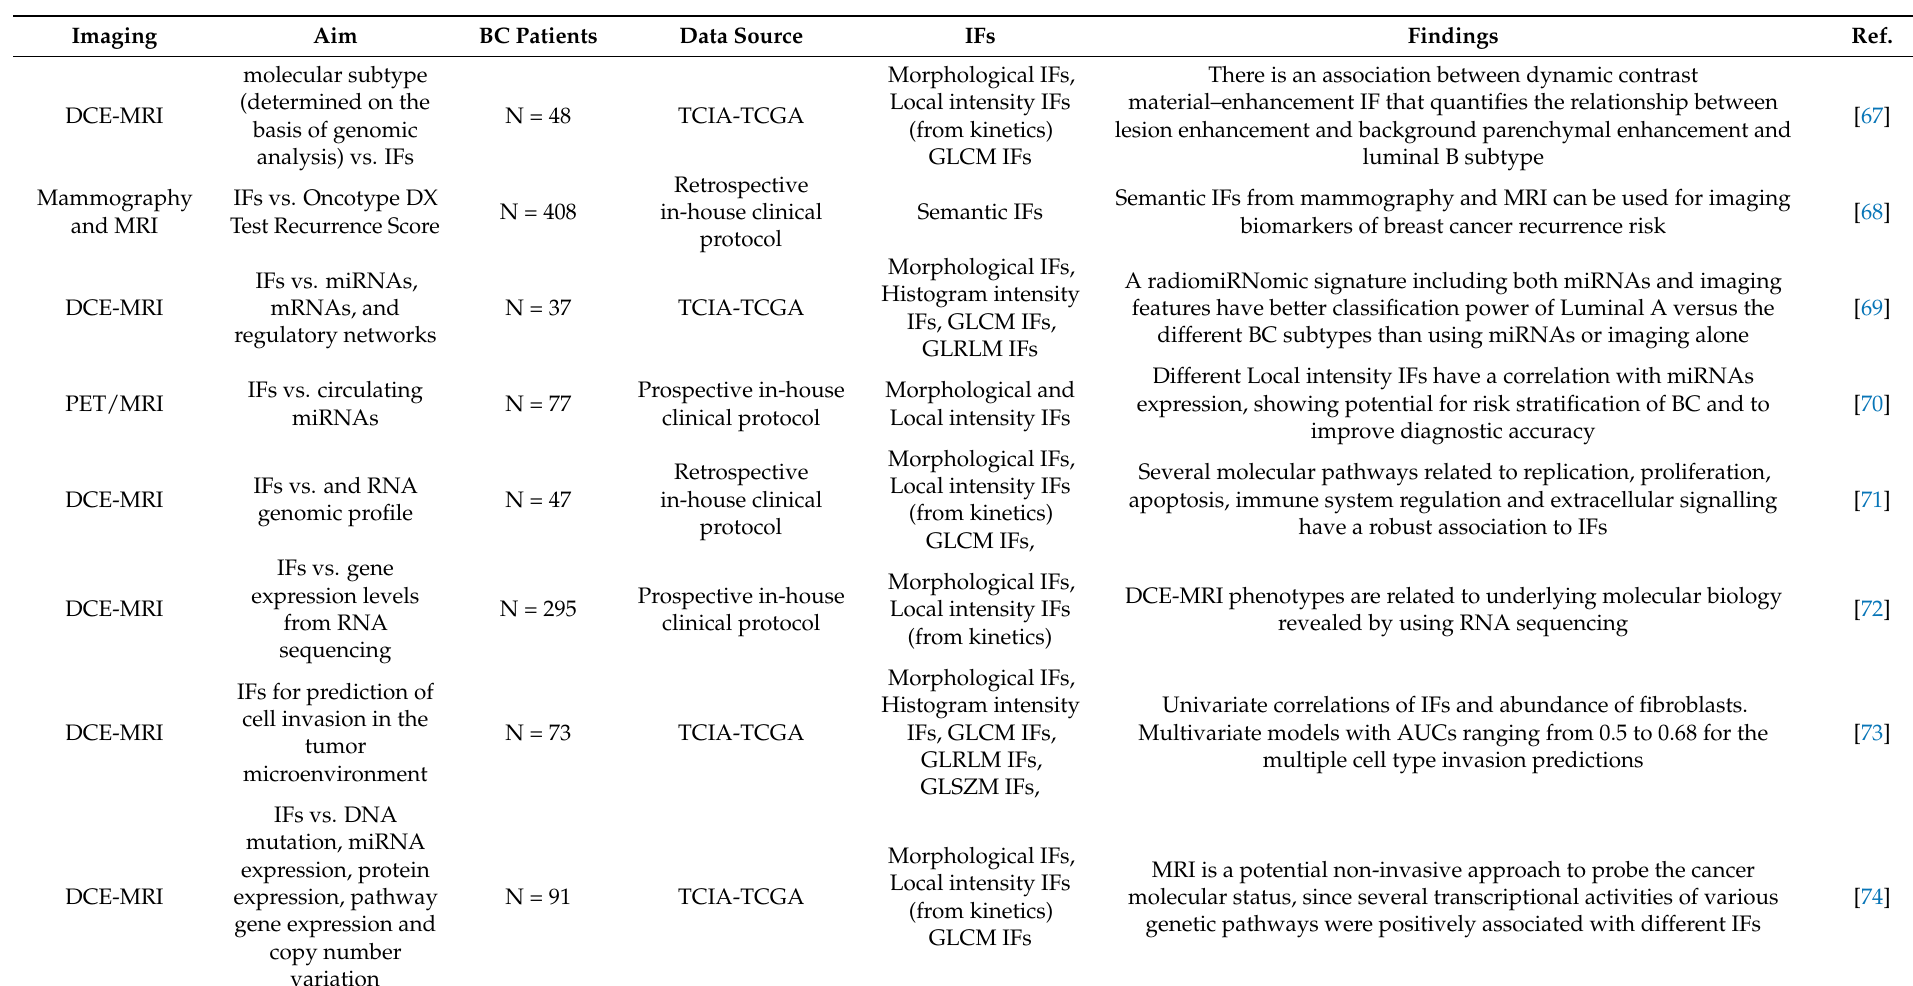
Table 1. Summary of literature findings on